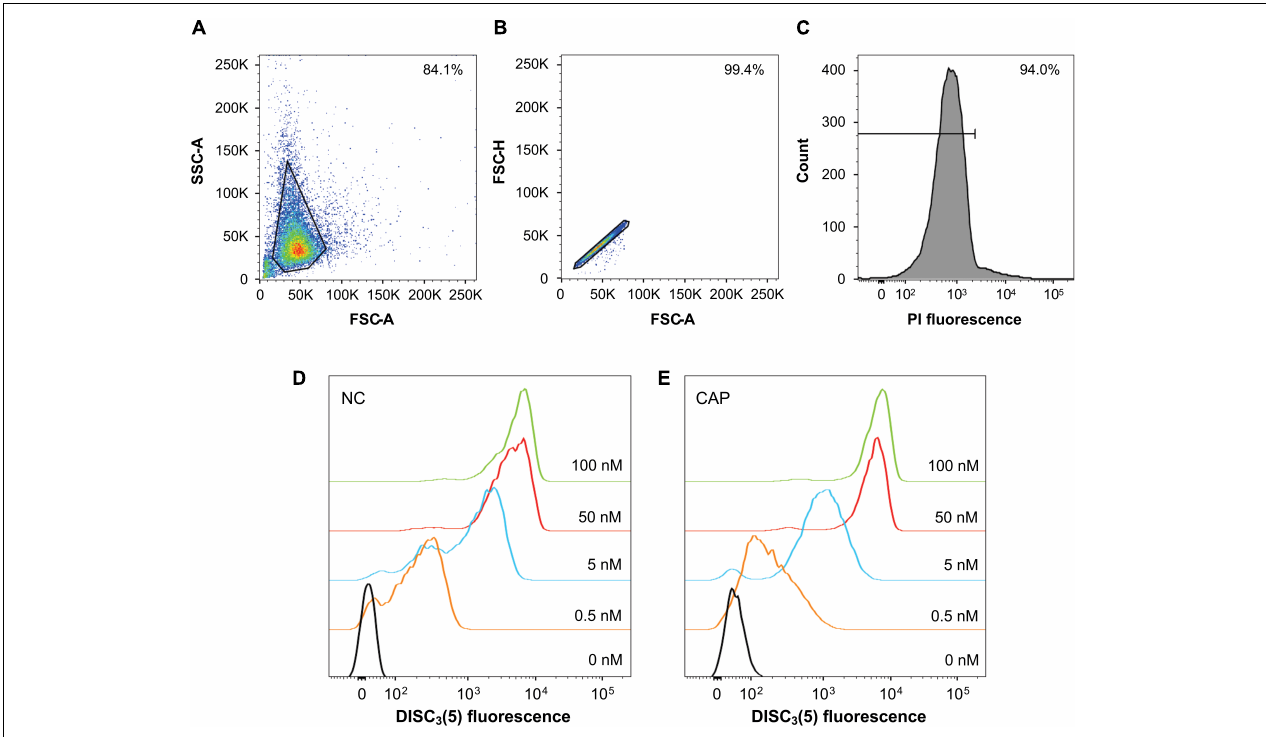
FIGURE 3 | Optimization of a flow cytometry assay to determine human sperm membrane potential. (A) Dot plot of side (SSC-A) vs. forward (FSC-A) scatter for each sample. Region of interest to eliminate cellular debris is shown. (B) The forward scatter height (FSC-H) vs. forward scatter area (FSC-A) profile was used to exclude cell aggregates and large cells from the analysis. (C) Histogram of PI fluorescence where live cells (low stain) were selected. (D) Human sperm were incubated with different dye concentrations in non-capacitating (left panel) and (E) capacitating conditions (right panel) by flow cytometry to determine optimal loading